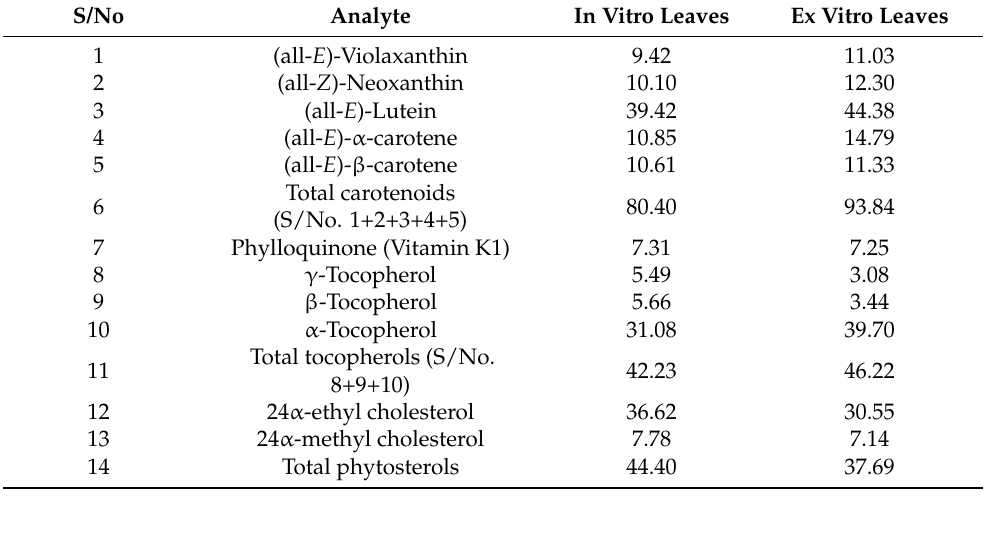
Table 1. Contents of major lipophilic metabolites from the KP-BG leaves, quantified ( µ g/g FW) by the LC–MRM–MS method.